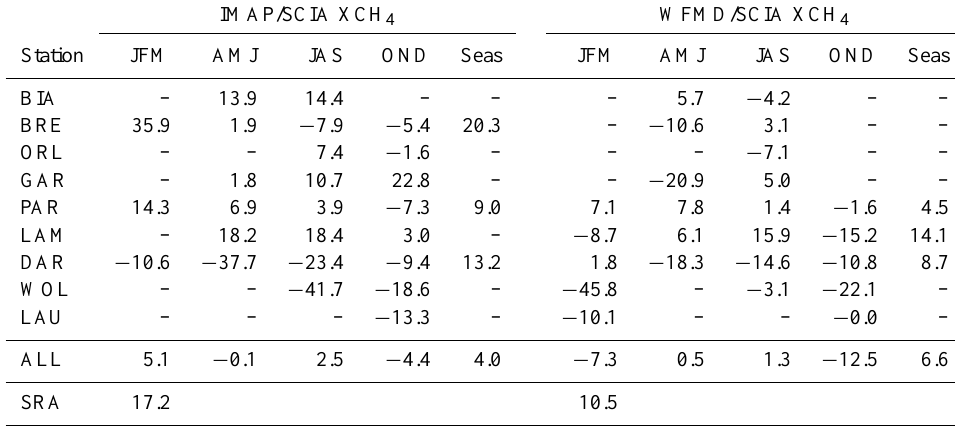
Table 8. IMAP and WFMD XCH 4 seasonal mean bias, seasonality and SRA results. All results are in ppb units.